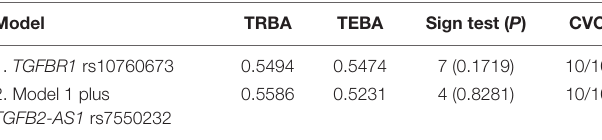
TABLE 7 | The results of GMDR of multiple loci and genes related to a significant myopic